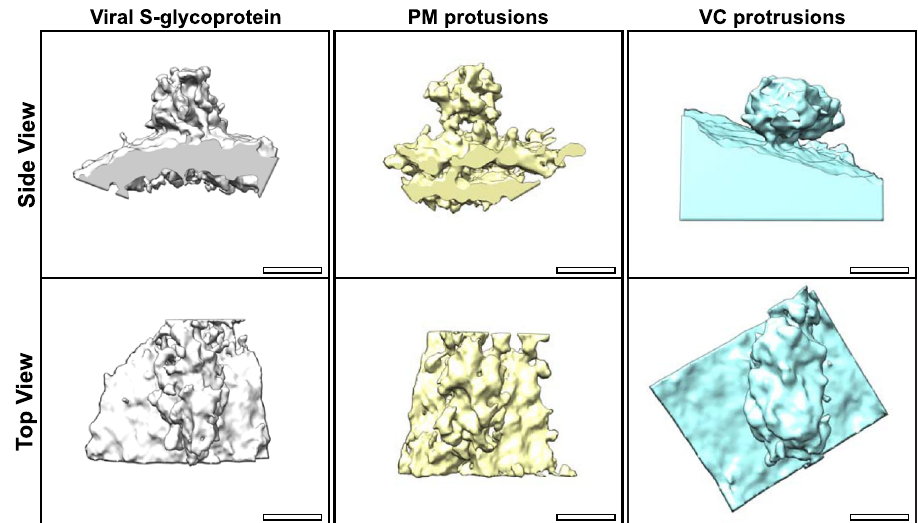
Fig. 8 Subtomographic averages of the plasma membrane (PM) and viral compartment (VC) protrusion have a similar structure to viral S glycoprotein. Scale bar 10